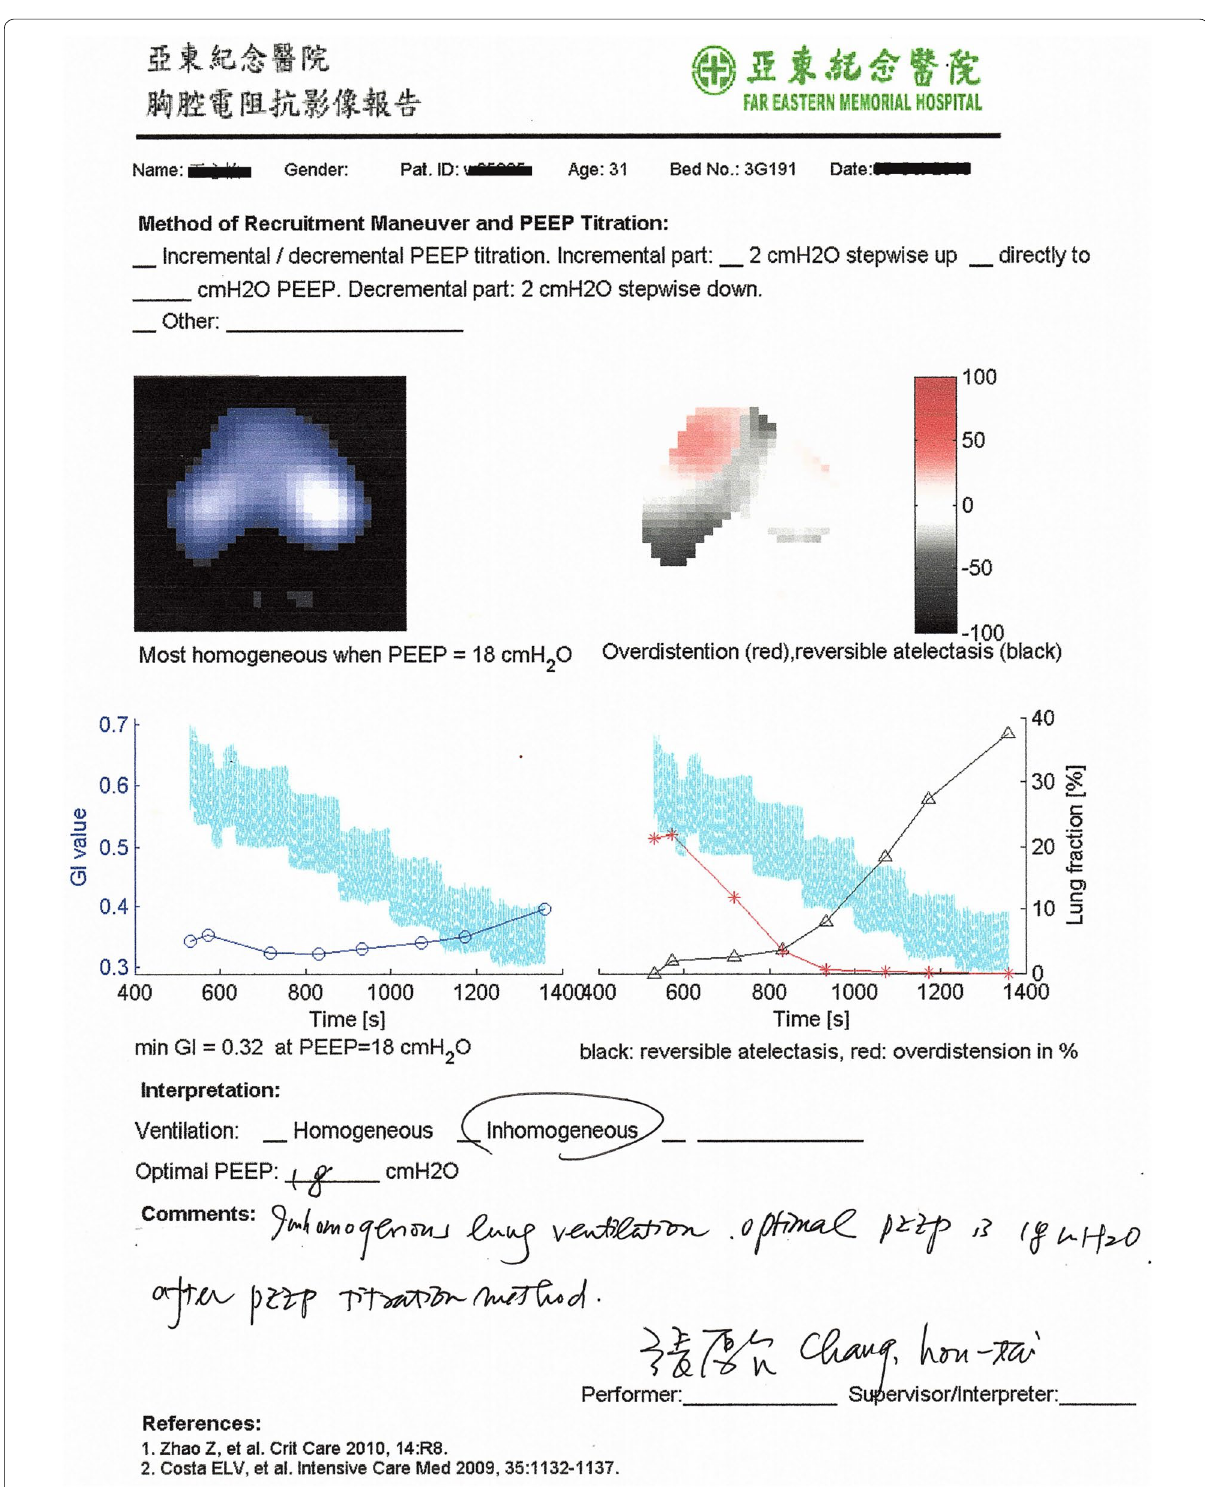
Fig. 2 PEEP titration report of an ARDS patient. The PEEP level selected based on EIT was the intercept point of cumulated collapse and overdistension percentages curves (triangle line and asterisk line). If the intercept point occurred between two PEEP steps, the selected PEEP corresponded to the PEEP step toward the lowest global inhomogeneity (GI) index (circle